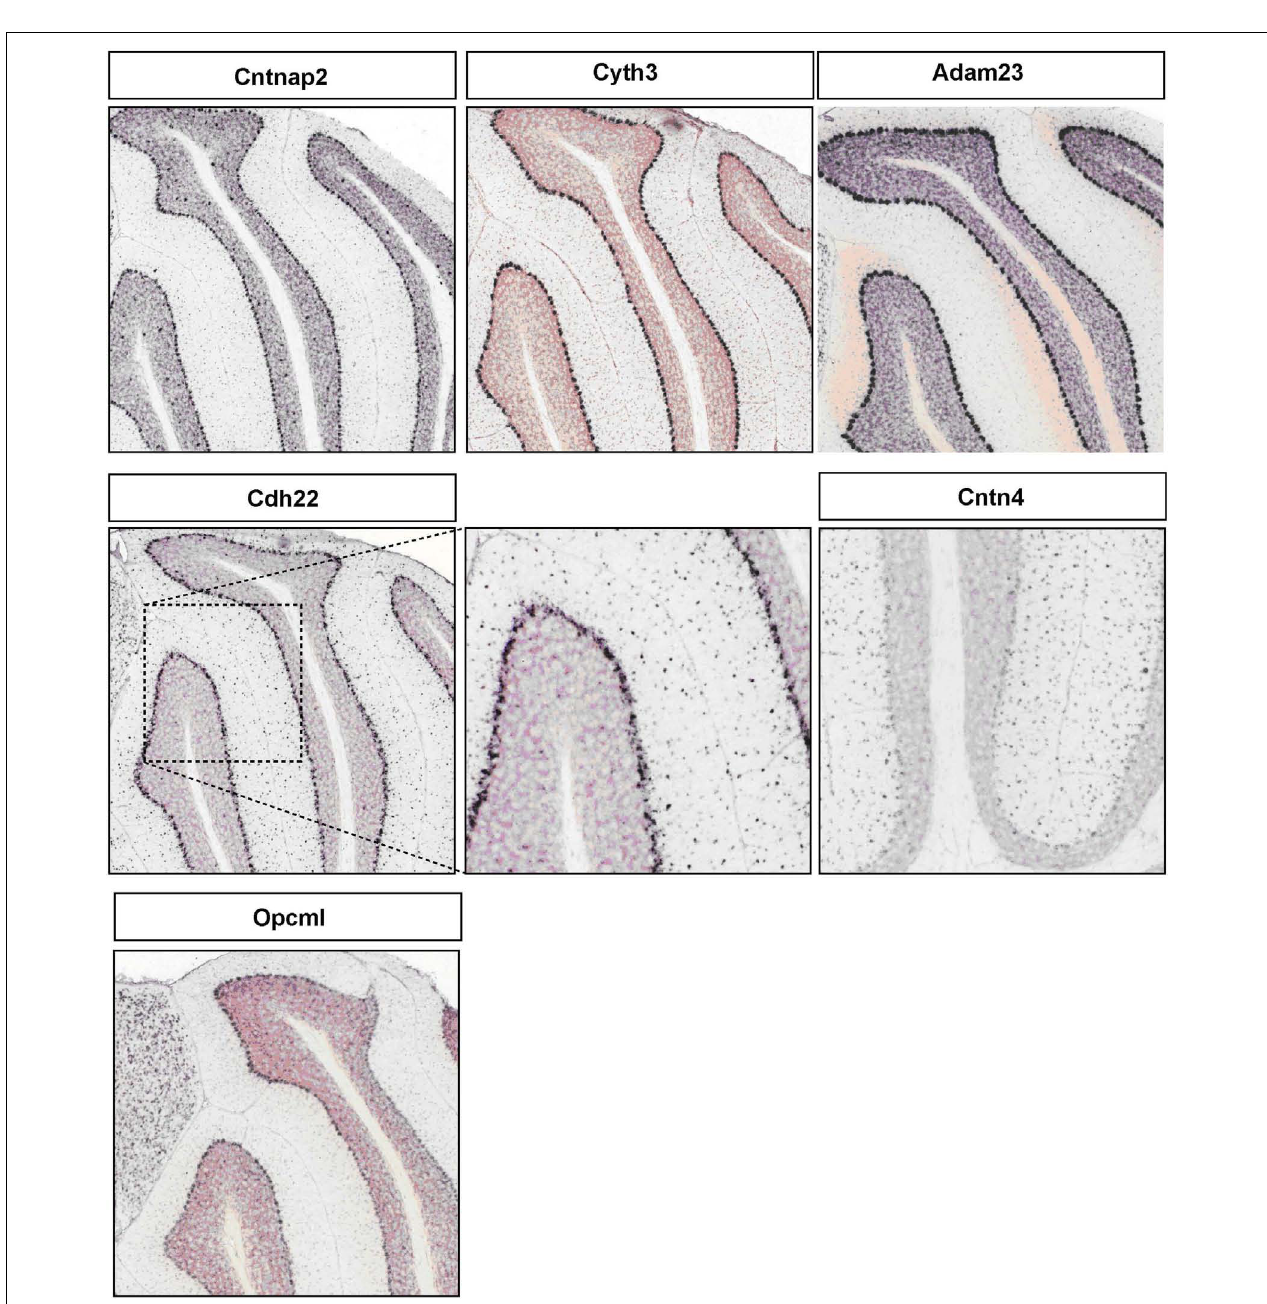
FIGUREA2 | Representative RNA in-situs fromAllen Brain mouse brain (only P56 time point available) images showing the PC specific expression of cell adhesion molecule transcripts, Cntnap2 , Cyth3 , Adam23 , and Opcml ; S/BC specific expression of Cdh22 and Cntn4